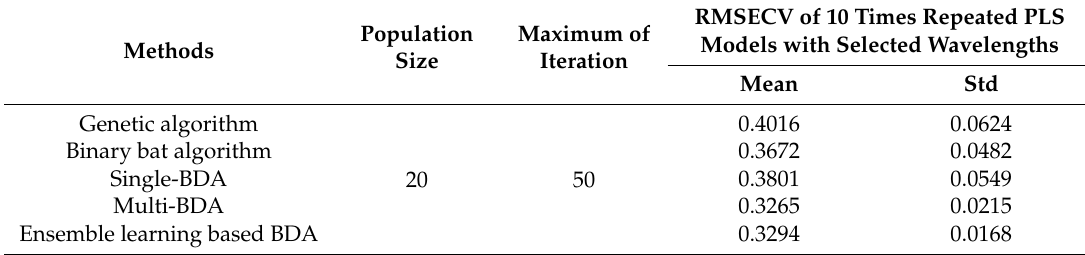
Table 4. Comparison between proposed BDA based methods and traditional